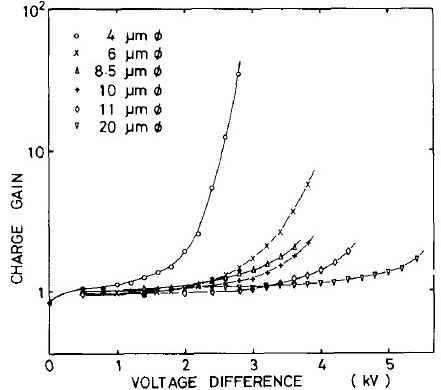
Figure 25. Charge gain as a function of applied voltage for different diameters of the anode wire in liquid Xe [28]. The maximum gains are limited by discharges.